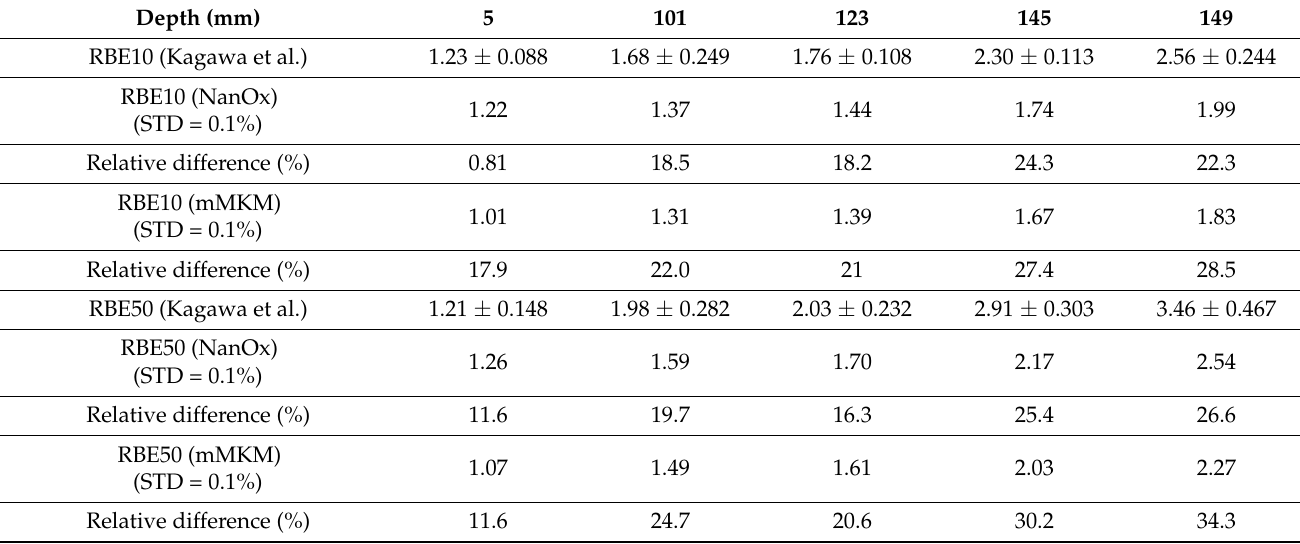
Table 5. RBE10 and RBE50 obtained with NanOx, MMKM models compared with Kagawa et al. at 5, 101, 123, 145 and 149 mm